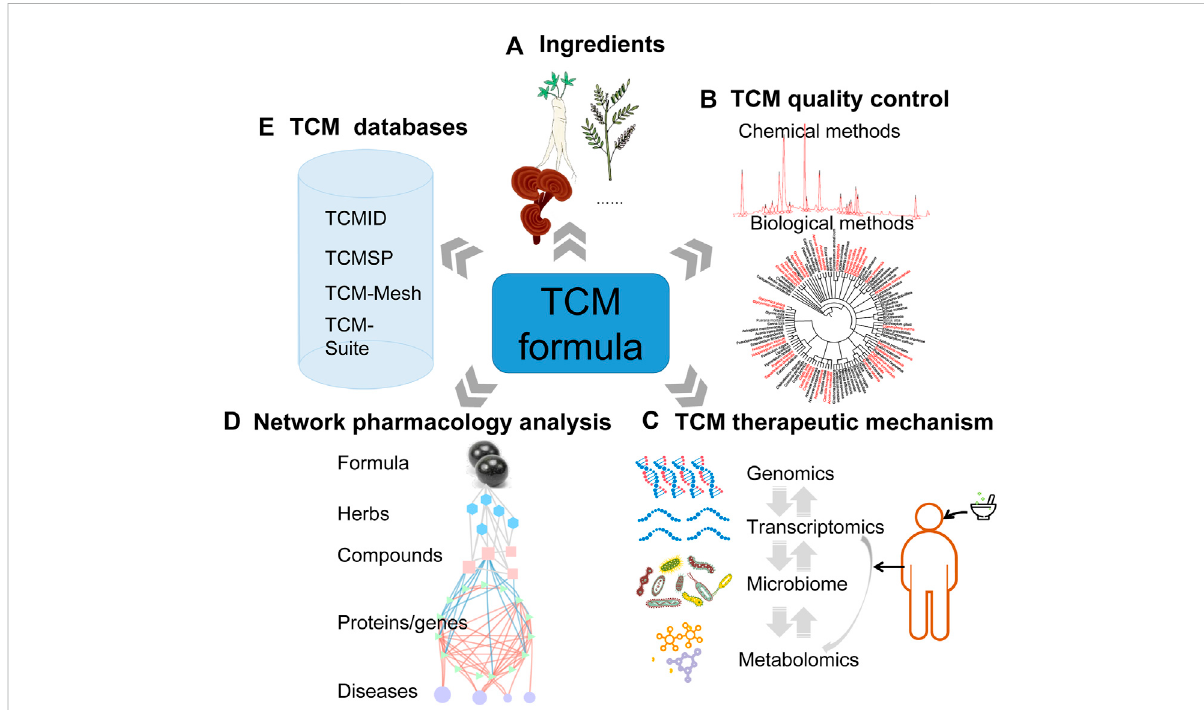
FIGURE 1 Systems biology-driven omics approaches have boosted TCM research from multiple perspectives. (A) Prescribed ingredients of TCM formula recorded in Chinese Pharmacopoeia (2020 edition). (B) The TCM quality control ( fi ngerprint-based chemical ingredients analysis methods and genomics-related biological ingredients analysis methods). (C) Multi-omics approaches including genomics, transcriptomics, microbiome, and metabolomics could be utilized for investigating the therapeutic mechanism of the TCM formula for treating various diseases. (D) Network pharmacologyanalysis for screening thebioactivecompounds andpotential targetsfor TCMformulasintreating various diseases. (E) The databases for TCM research. The current databases serve as a link across TCM formulas, ingredients, bioactive compounds, targets (proteins/genes), and various